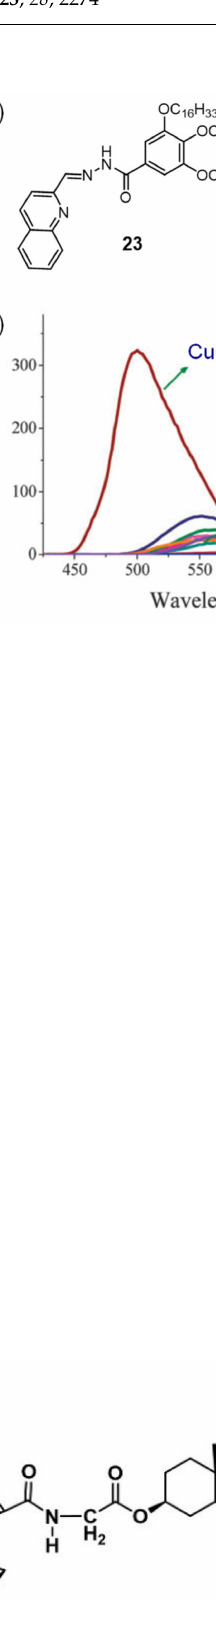
Figure 9. Chemical structure of the gelator 27 and responsiveness of the ethyl acetate gel of com- pound 27 to the oxidant (NH 4 ) 2 Ce(NO 3 ) 6 . Reprinted with permission from Ref. [56]. Copyright (2008),